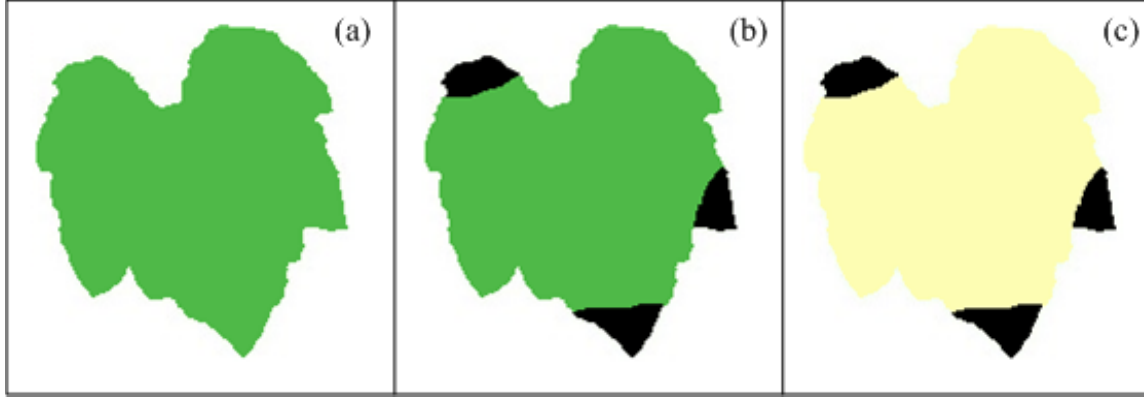
Figure 2. ( a ) Pumpkin leaf with homogeneous green colour. ( b ) Non-chlorotic pumpkin leaf with necrotic areas. ( c ) Chlorotic pumpkin leaf with necrotic